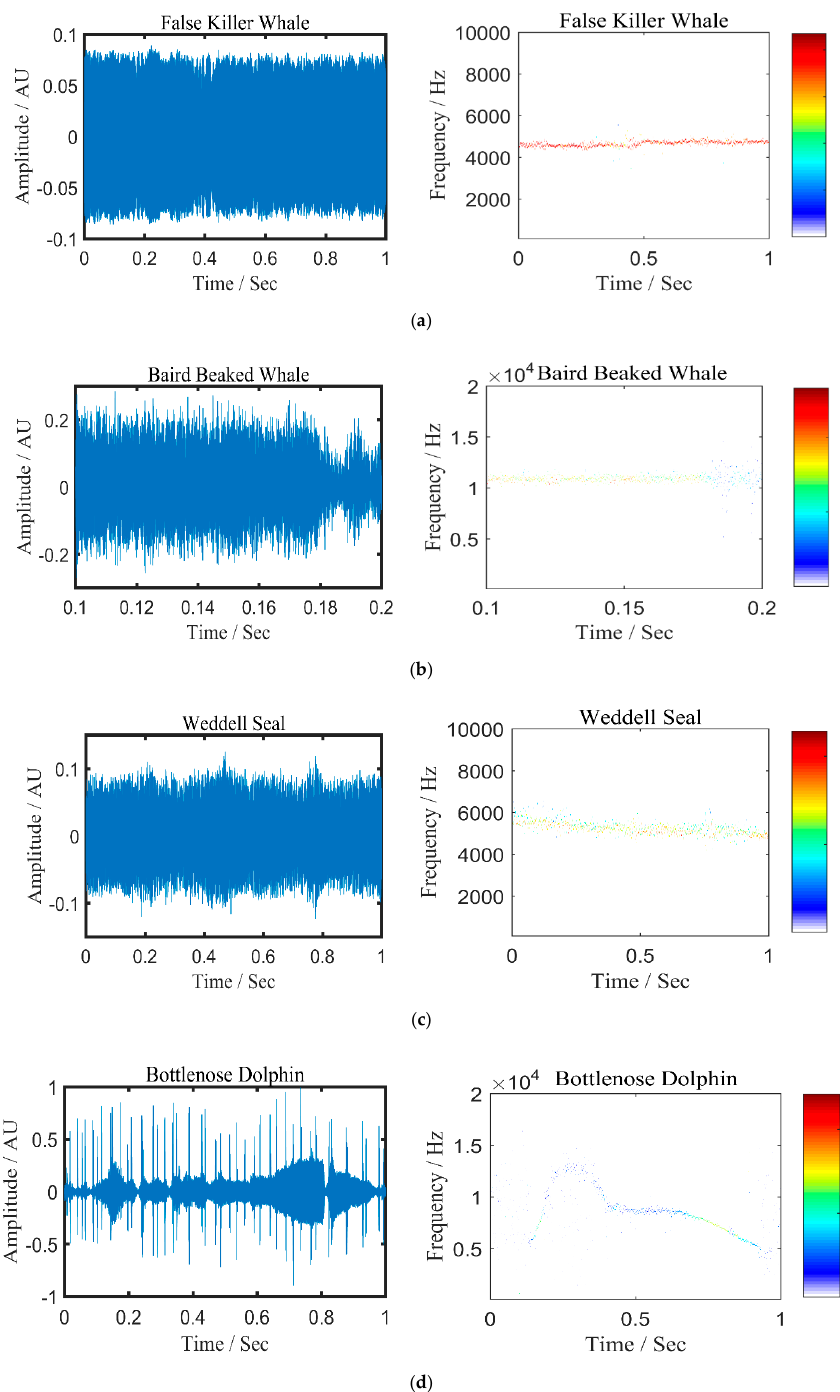
Figure 8. Four kinds of animal sound signals and the time-domain diagram processed by ACMD method (( a ). The time-domain diagram of the False Killer Whale sound signal and the time–frequency diagram processed by the ACMD method a, where α = 1 × 10 − 3 , β = 1 × 10 − 4 ; ( b ). The time-domain diagram of the Baird’s Beaked Whale sound signal and the time–frequency diagram processed by the ACMD method a, where α = 1 × 10 − 3 , β = 1 × 10 − 4 ; ( c ). The time-domain diagram of the Weddell Seal sound signal and the time–frequency diagram processed by the ACMD method a, where α = 1 × 10 − 3 , β = 1 × 10 − 4 ; ( d ). The time-domain diagram of the Bottlenose Dolphin sound signal and the time–frequency diagram processed by the ACMD method a, where α = 1 × 10 − 3 , β = 1 × 10 − 4